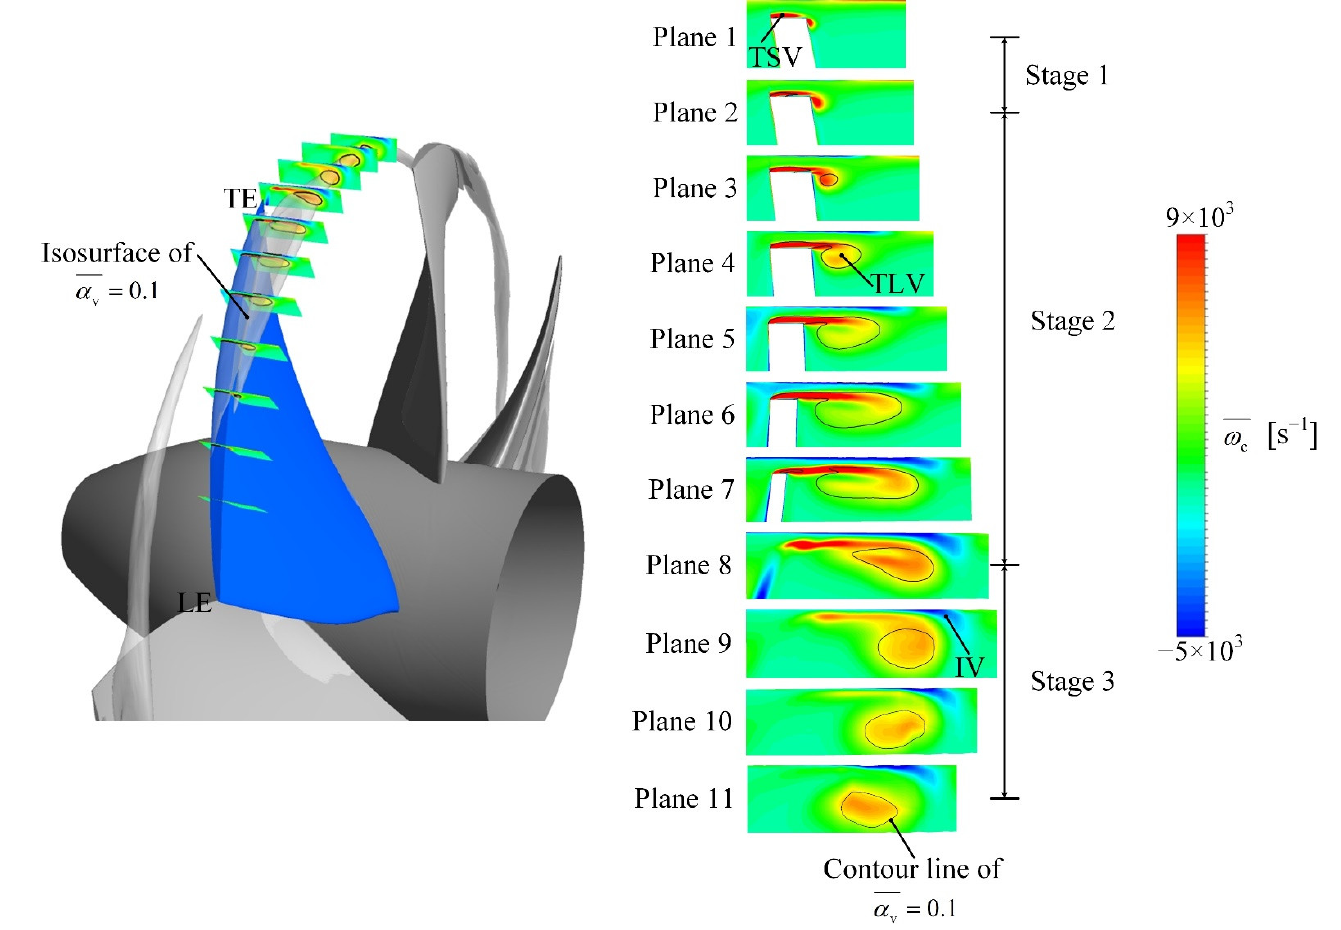
Figure 7. Vortex evolution with cavitation.